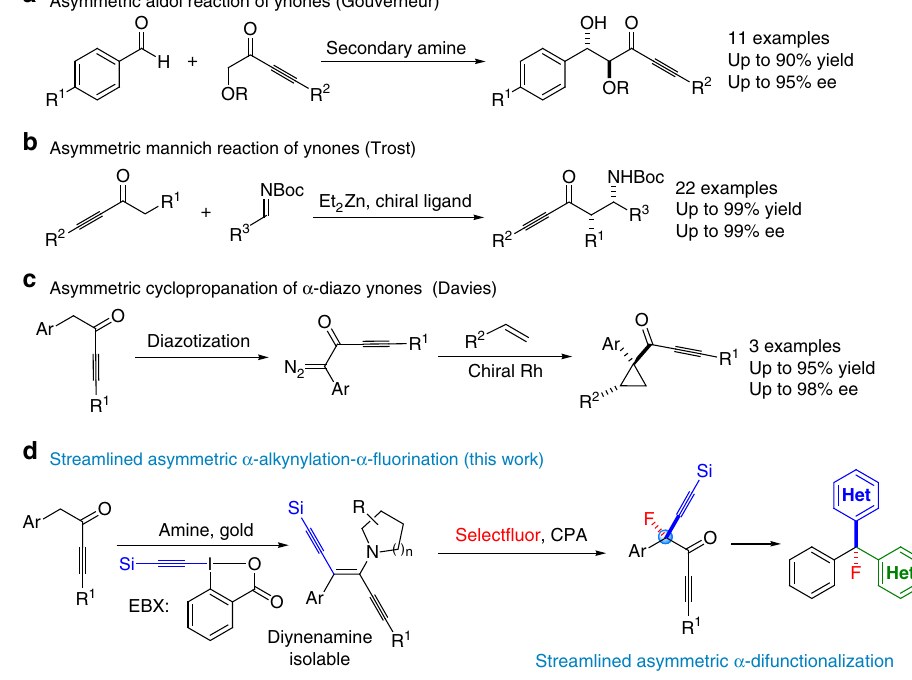
Fig. 1 Asymmetric α -functionalization of ynones. a Enantioselective aldol reaction of ynones; b enantioselective Mannich reaction of ynones; c generation of ynones with an α -quaternary chiral center using cyclopropanation; d asymmetric α -alkynylation – α - fl uorination of